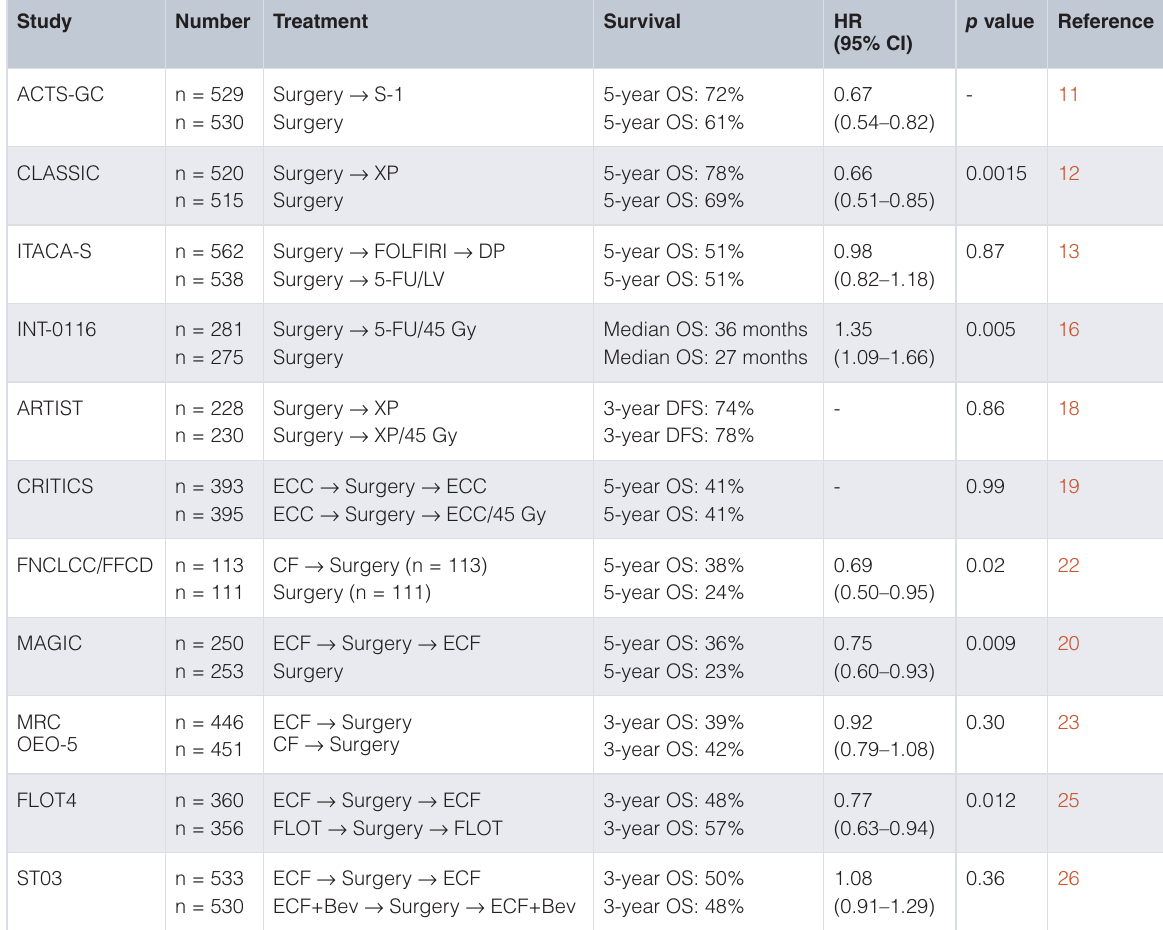
Table 1. Preoperative treatment trial for localized gastric